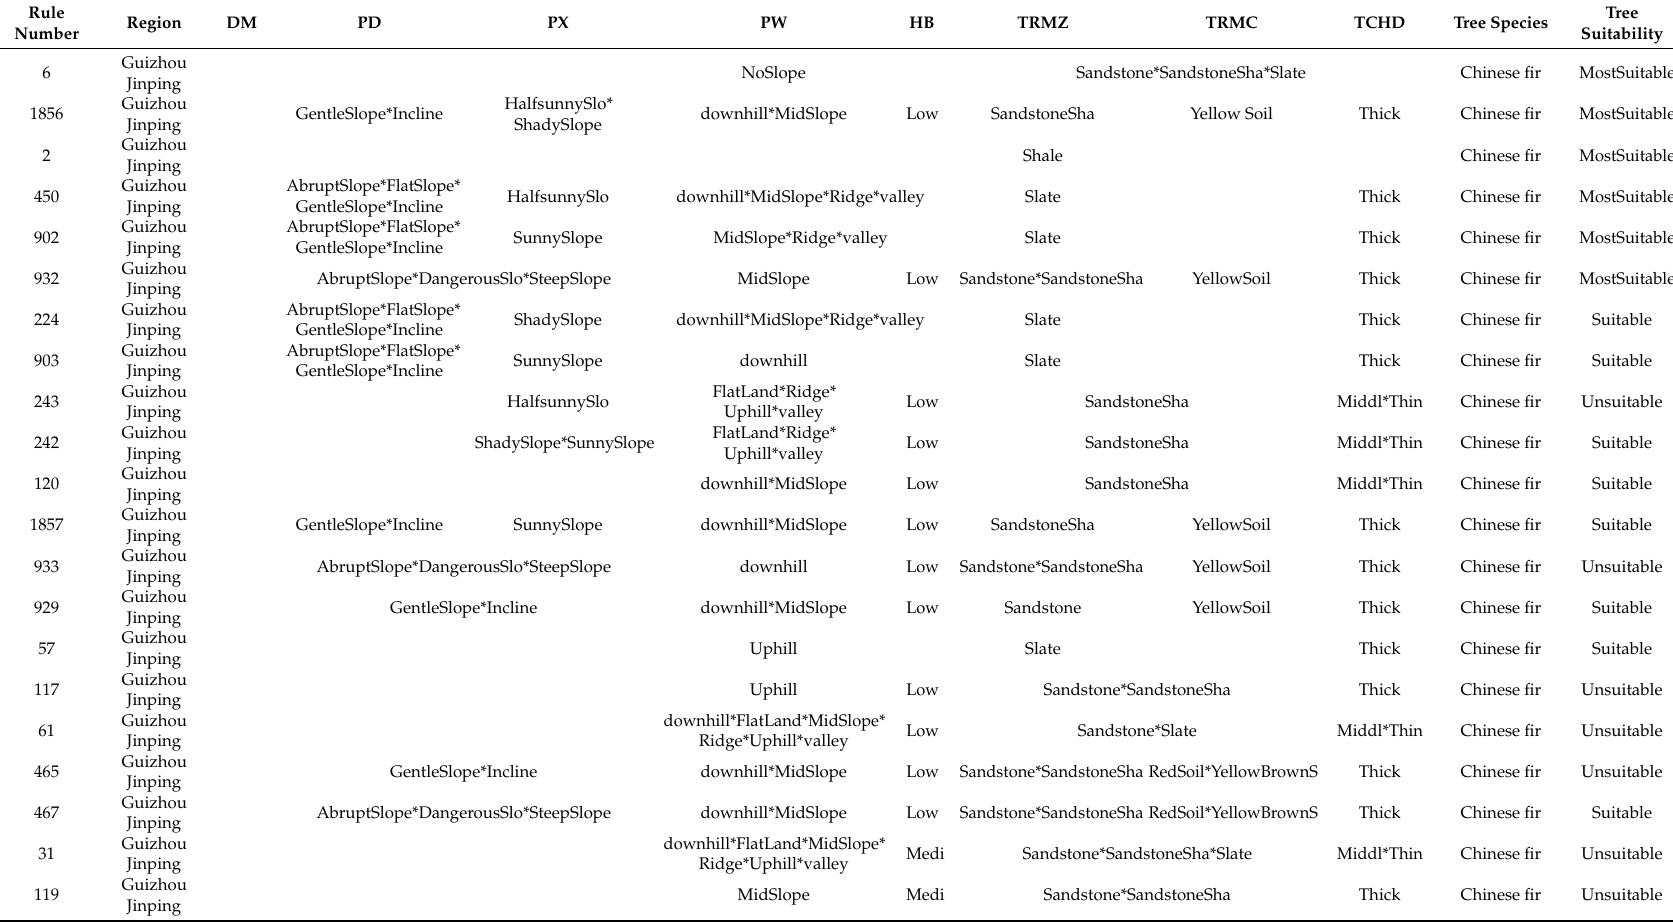
Table A1. Tree suitability site rule table for Chinese fir and Masson Pine in Jinping County, Guizhou